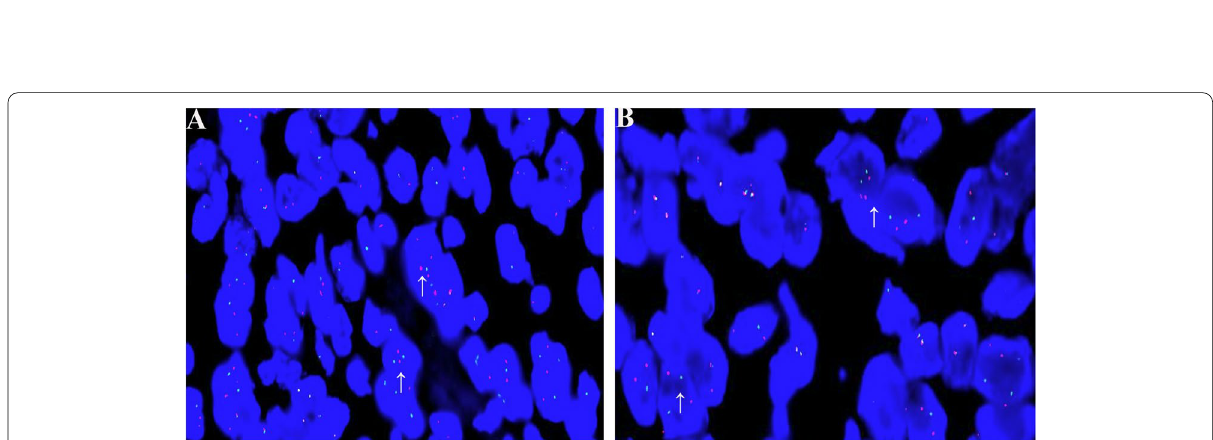
Fig. 3 Fluorescence in situ hybridization analyses for ETV6 breaks apart in SBC. FISH images showed ETV6 break-apart signals in epithelial